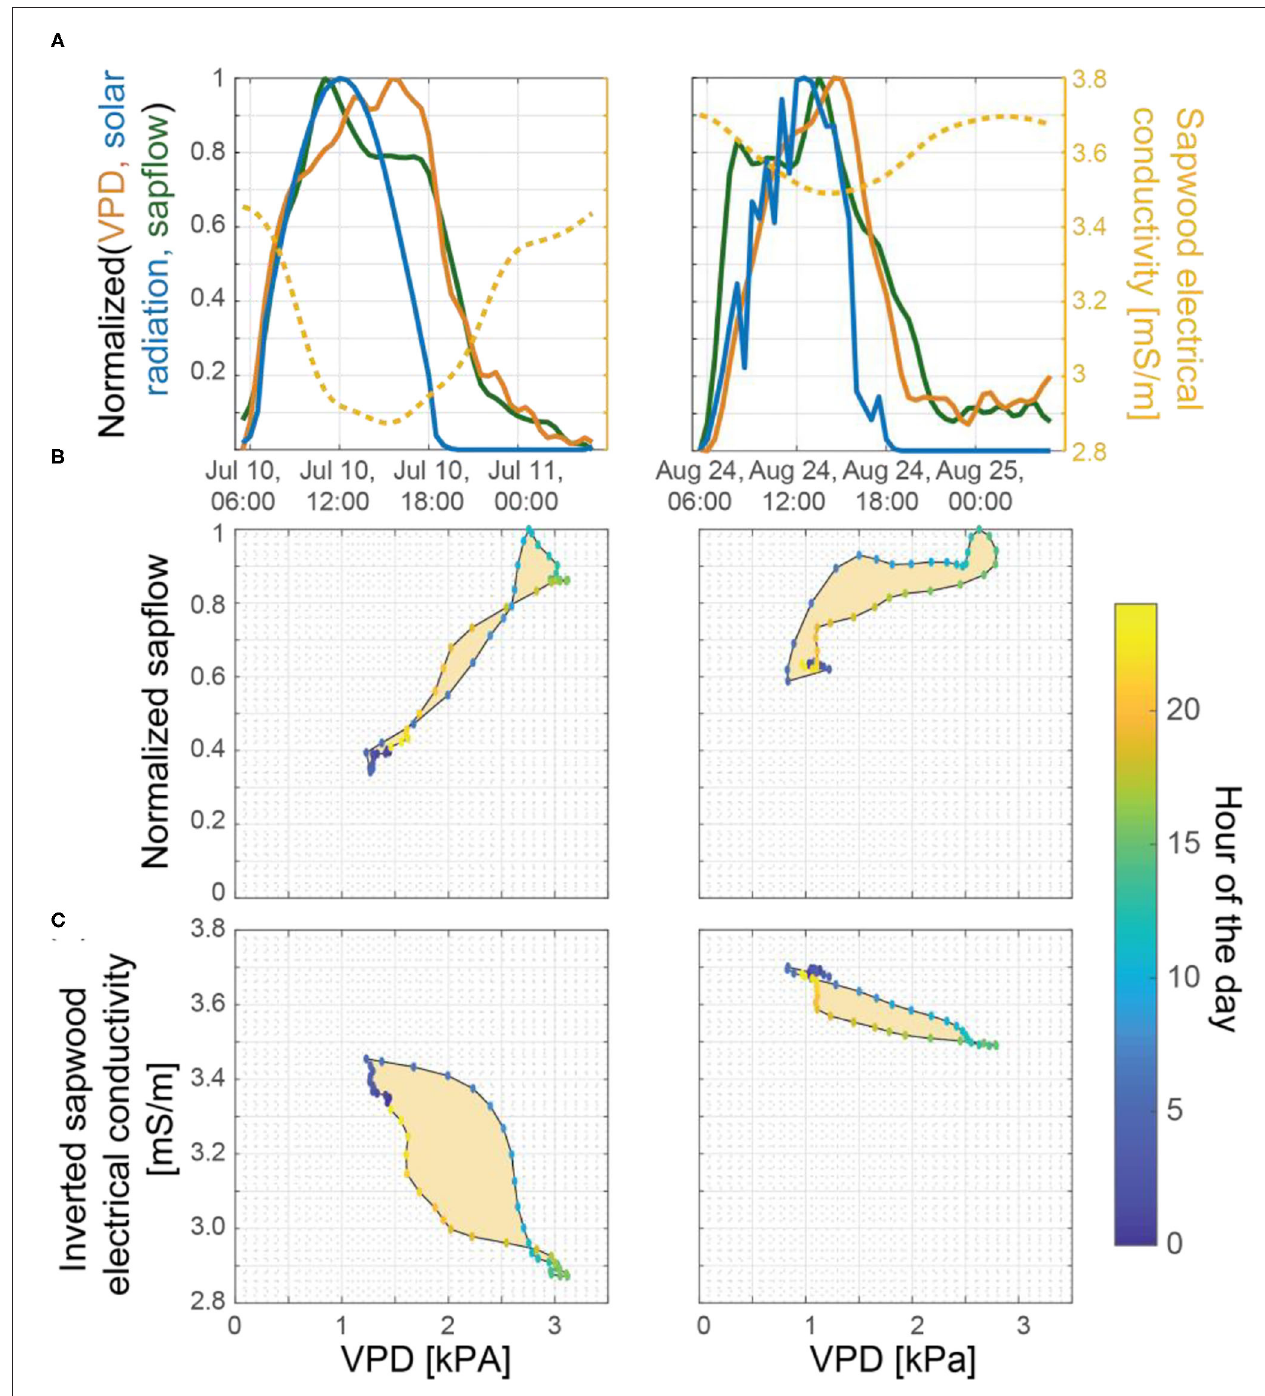
FIGURE 7 | (A) Normalized VPD (orange line), solar radiation (blue line), and sapflow (green) with inverted sapwood electrical conductivity (yellow line) on July 10 and August 24, 2018. These 2 days were selected for comparison because both days were considered to be mostly sunny, high VPD days, that occurred at the tail end of multi-day dry periods, but also because soil moisture availability was limited by August 24 and not on July 10 ( Figure 3A ), providing a contrast. Hysteresis between VPD and (B) sapflow and (C) inverted sapwood electrical conductivity.